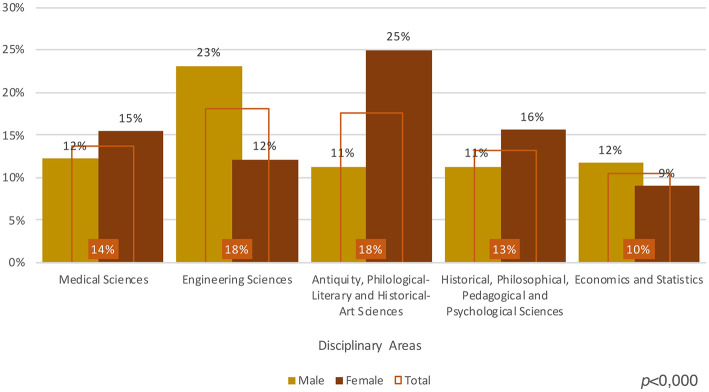
Scientific areas, incidence by gender and total (Source: our survey).